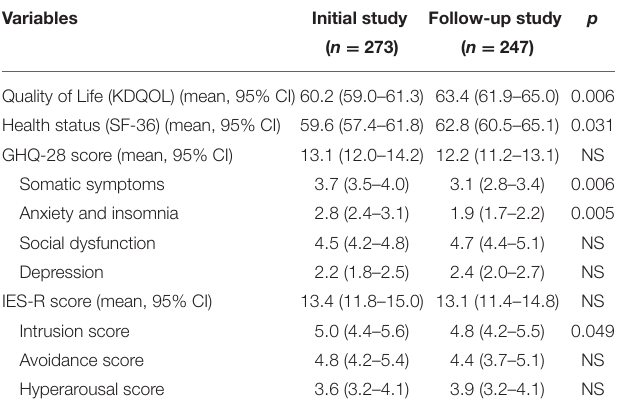
TABLE 2 | Psychological profiles, metal health, and quality of life of the patients. Variables Initial study Follow-up